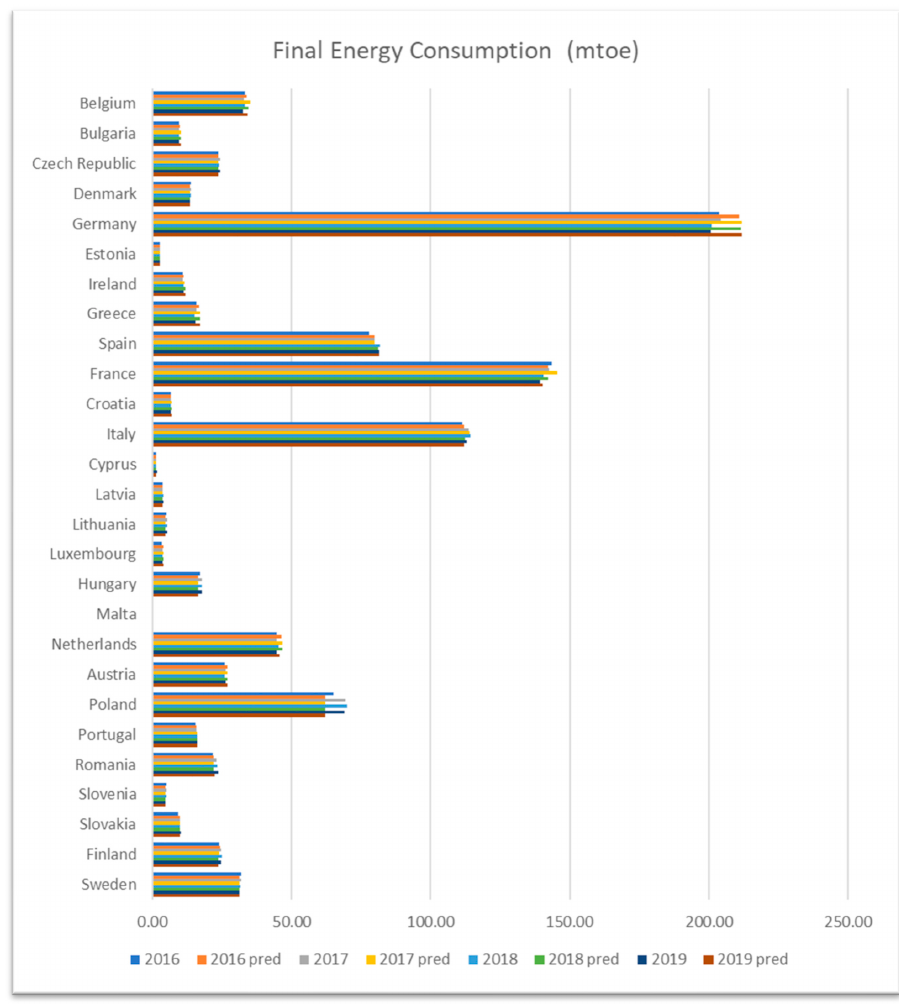
Figure 11. Annual variation comparisons for EU-27 countries between the final energy consumption (observed) and the prediction by OpEnergy for the years 2016, 2017, 2018, and 2019.